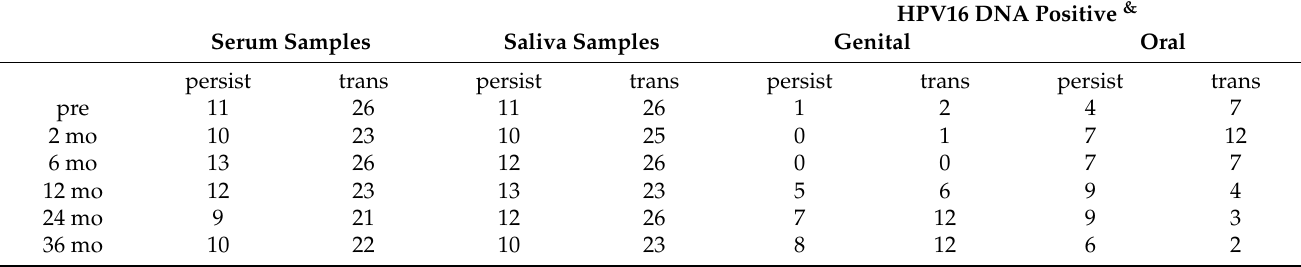
Table 1. Number of samples at different time-points in persistent * and transient # oral infec- tion